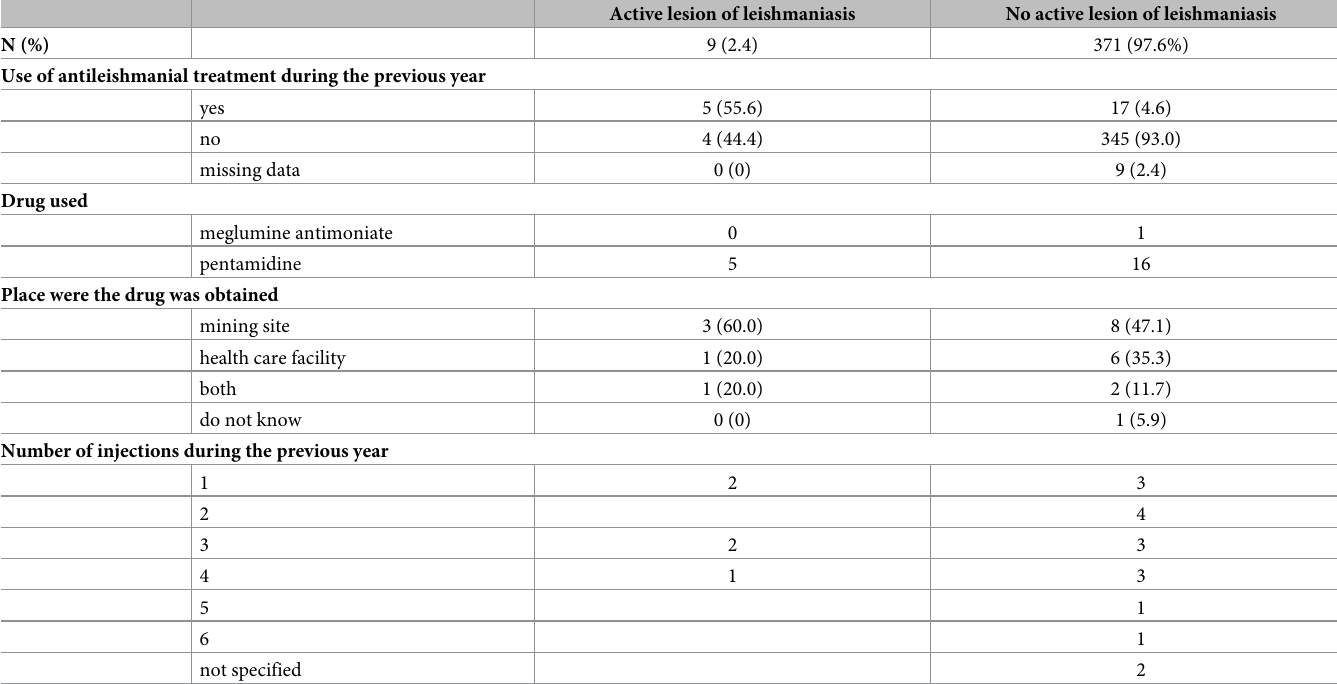
Table 5. Use of anti-leishmanial treatment in the previous year among gold miners included in the 2019 study along the Maroni